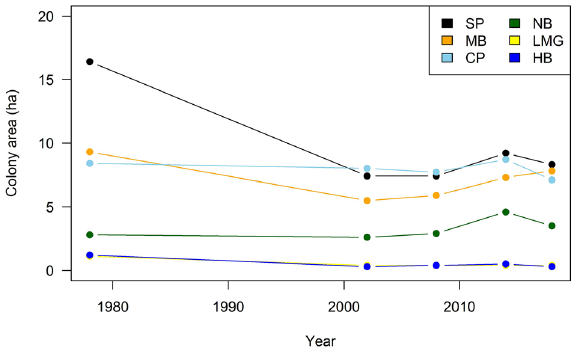
Figure 1. Changes in estimated flesh-footed shearwater colony areas on Lord Howe Island 1978–2018 (ha) (SP, Stevens Point; MB, Middle Beach; CP, Clear Place; NB, Neds Beach; LMBG, Little Muttonbird Ground; HB, Hunter Bay).